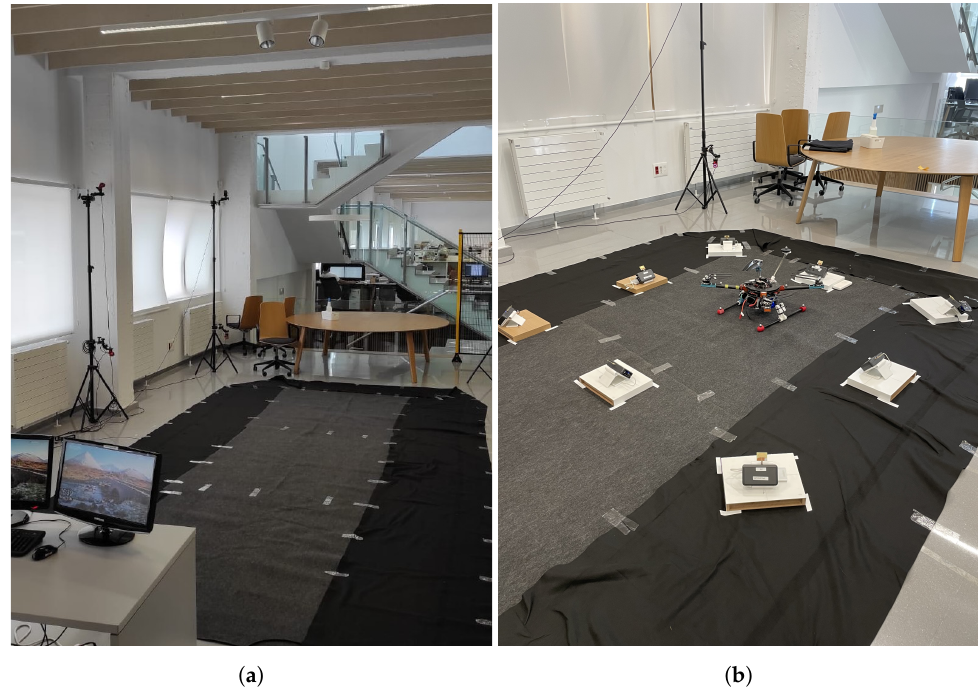
Figure 7. ( a ) Location of the tests and ( b ) set-up for the measurements. Table 3. Positions of the anchors during the